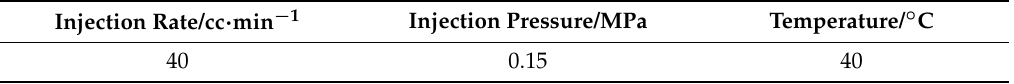
Table 4. Parameters of resign transfer molding (RTM) process.